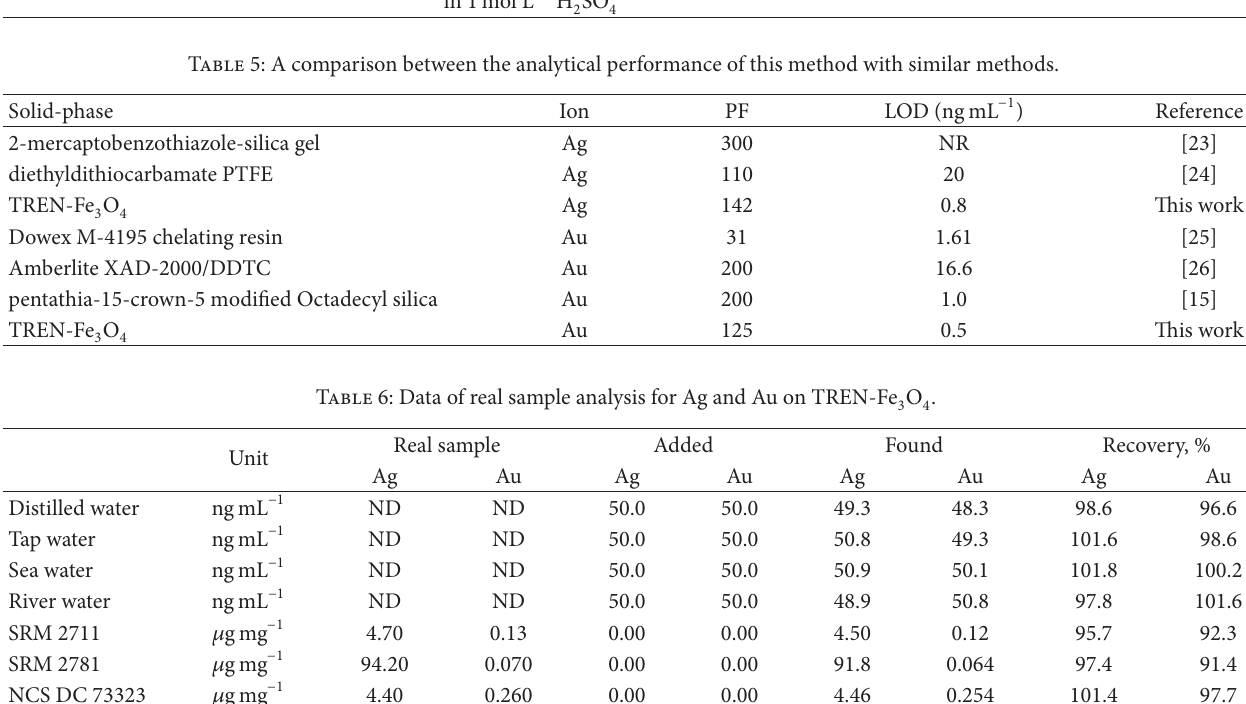
T 5: A comparison between the analytical performance of this method with similar methods.